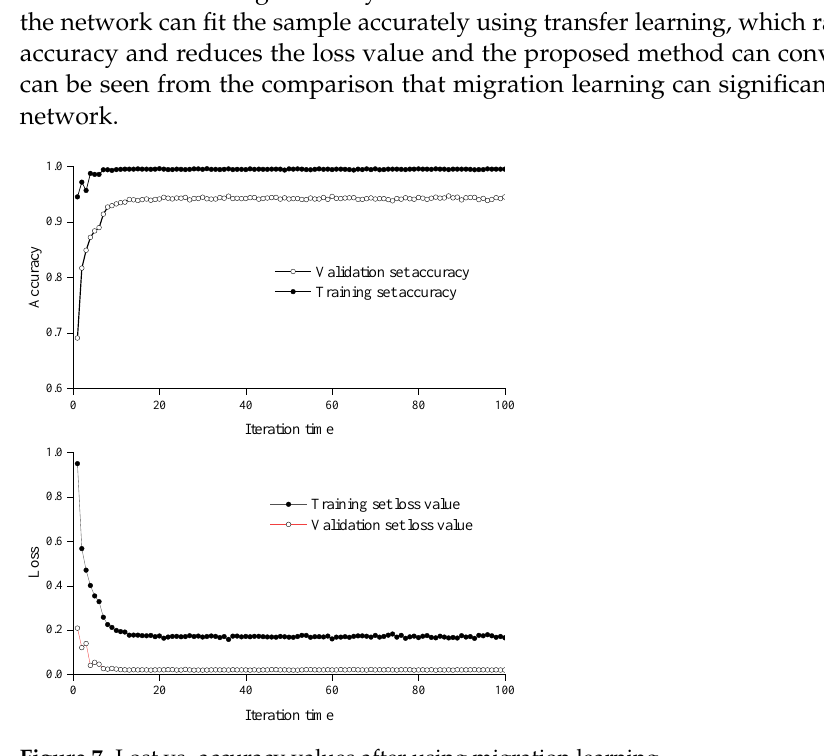
Figure 7. Lost vs. accuracy values after using migration learning.